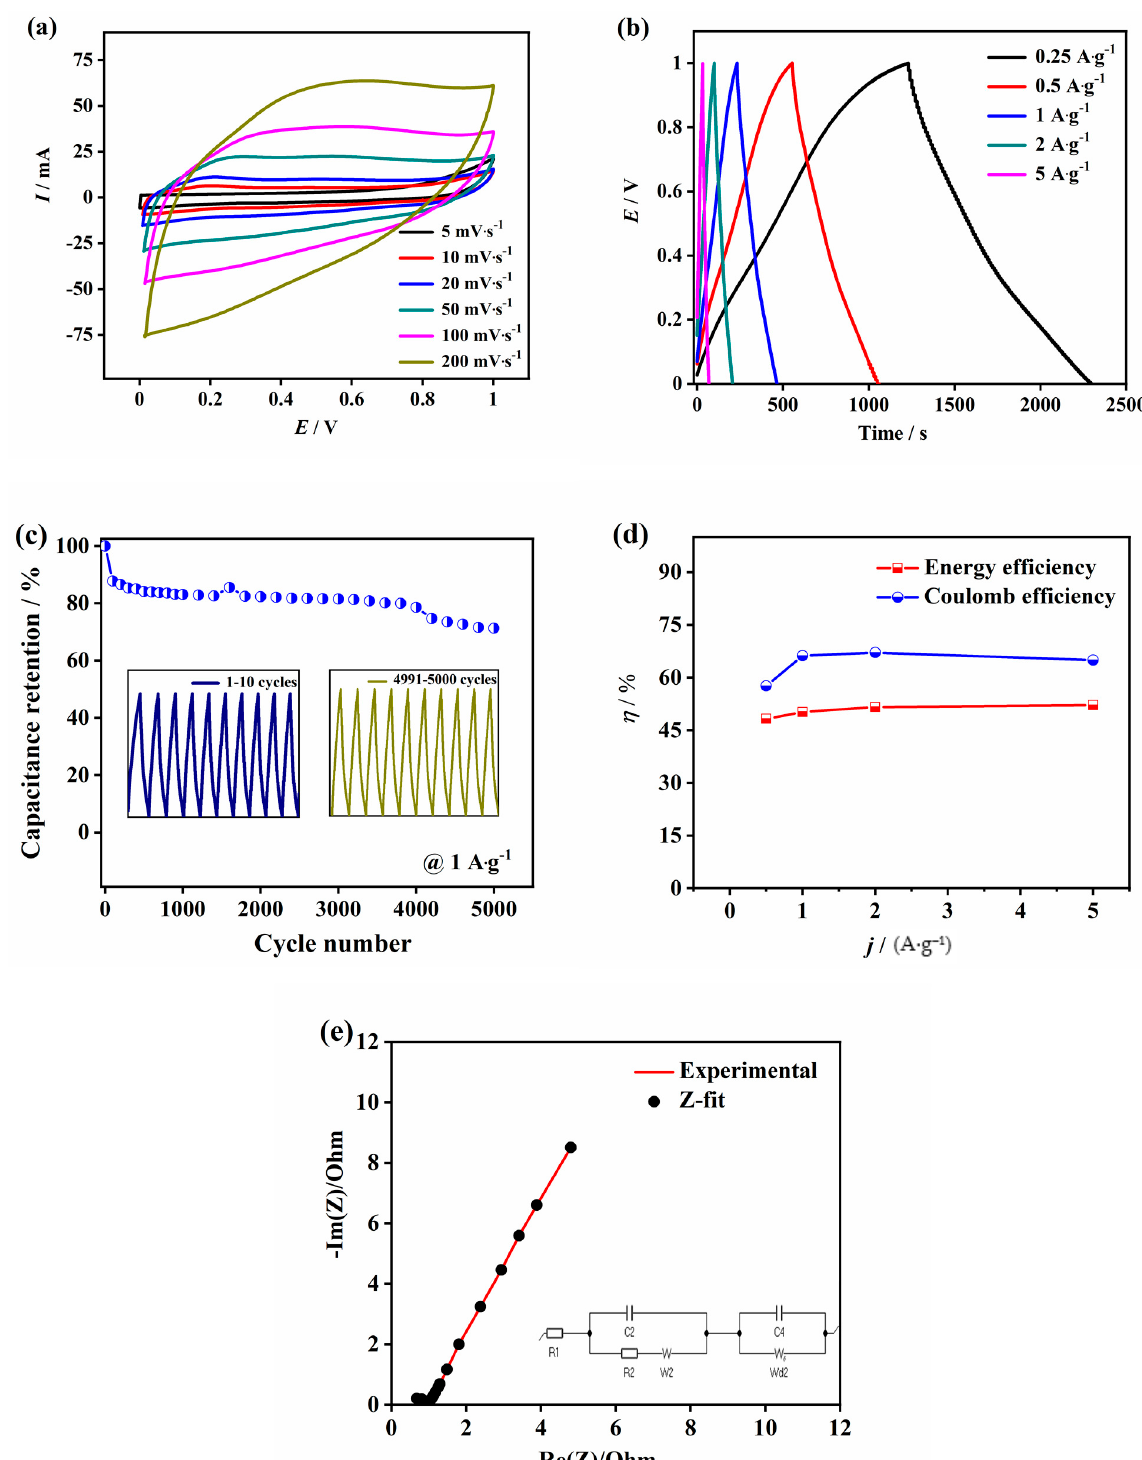
Figure 4. Electrochemical analysis of FCNT-MnO 2 in a two-cell configuration with 3 M KOH electrolyte ( a ) cyclic voltam- metry, ( b ) galvanostatic charge-discharge, ( c ) cyclic performance from GCD, with inset showing first and last 10 cycles of 5000 cycles, ( d ) coulombic efficiency and energy efficiency vs. current density plot, and ( e ) Nyquist plot of experimental data and Z-fit, with its corresponding equivalent circuit.